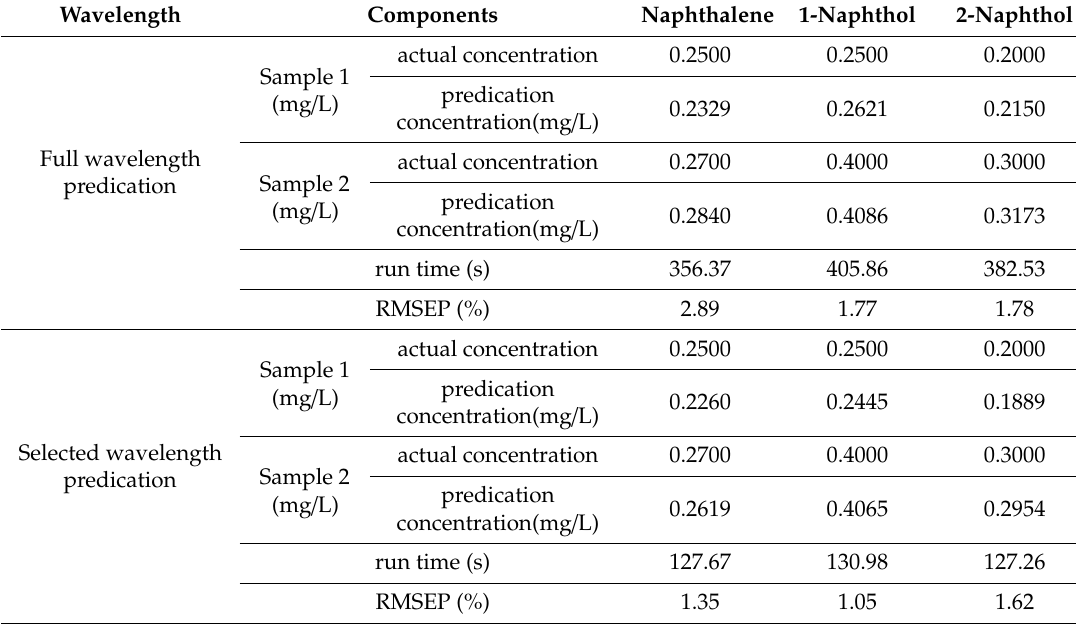
Table 4. Predicted concentrations of the three components in the test